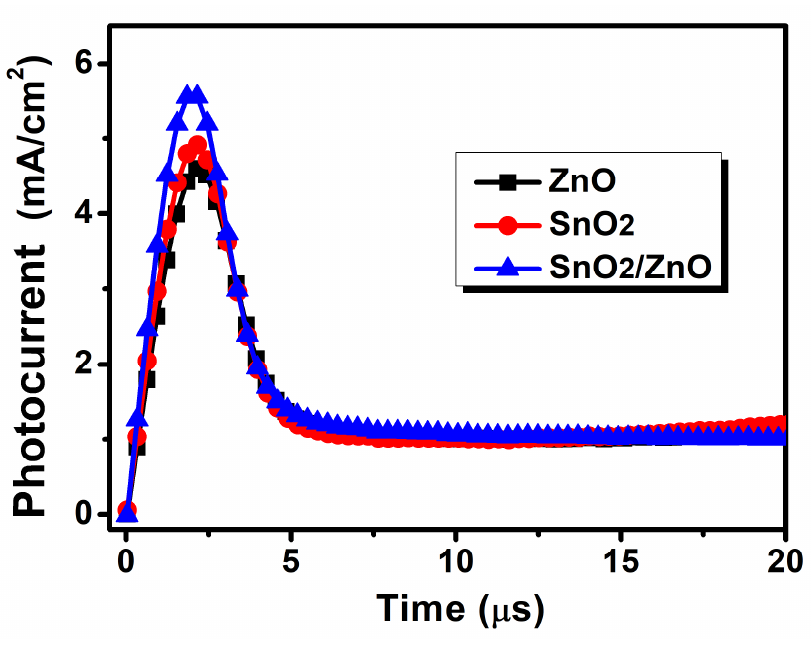
Figure 3. Photo-CELIV curves of the device with different cathode buffer layers.